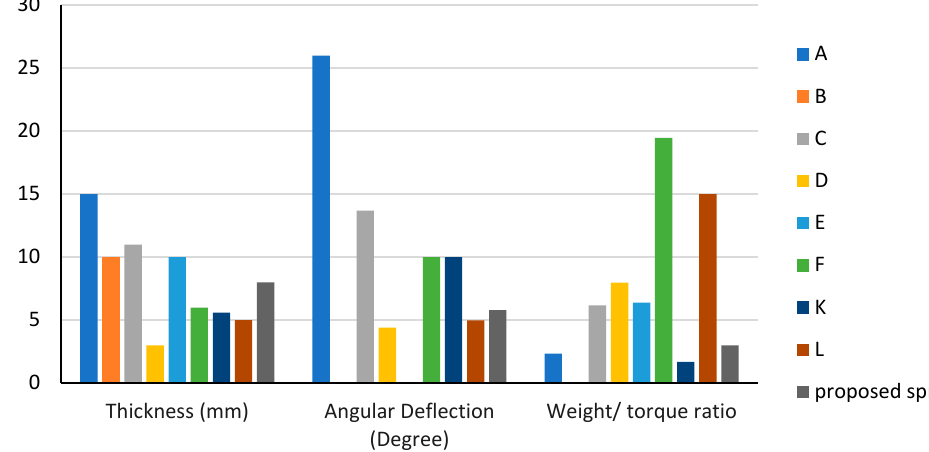
Figure 14. Spring characteristics of thickness, angular deflection, and weight-to-torque ratio. (A) [15]. (B) [10]. (C) [16]. (D) [7]. (E) [17]. (F) [18]. (K) [25,26]. (L) [22,23].